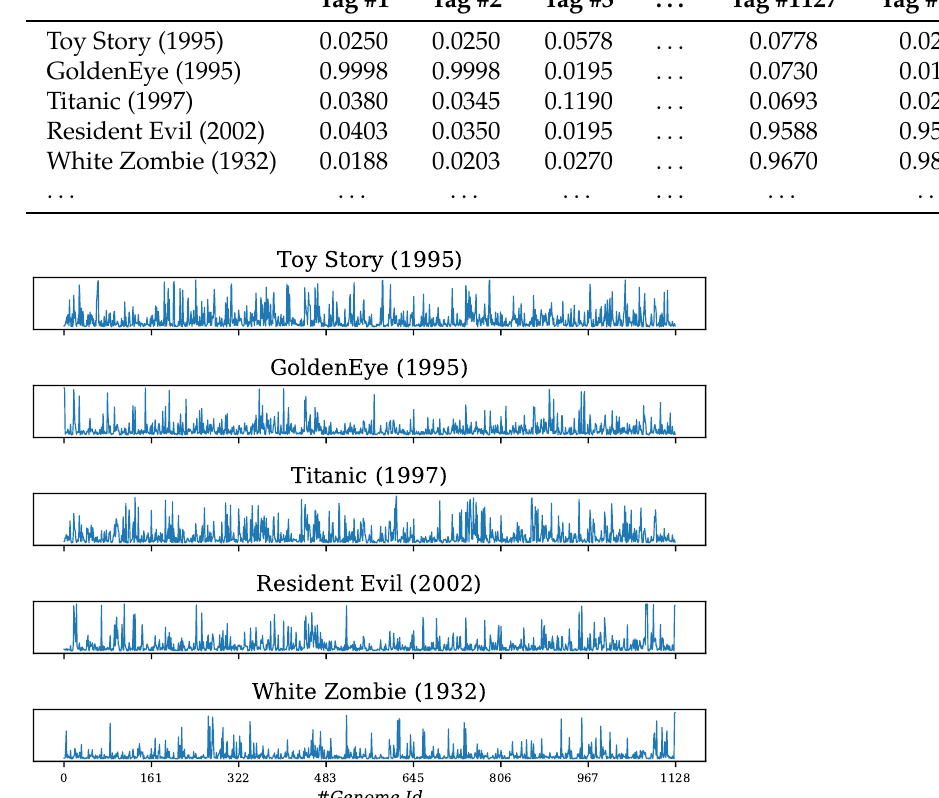
Figure 2. Random vibration signals of the 5 movies in MovieLens 20 M dataset resembled by Tag Genome